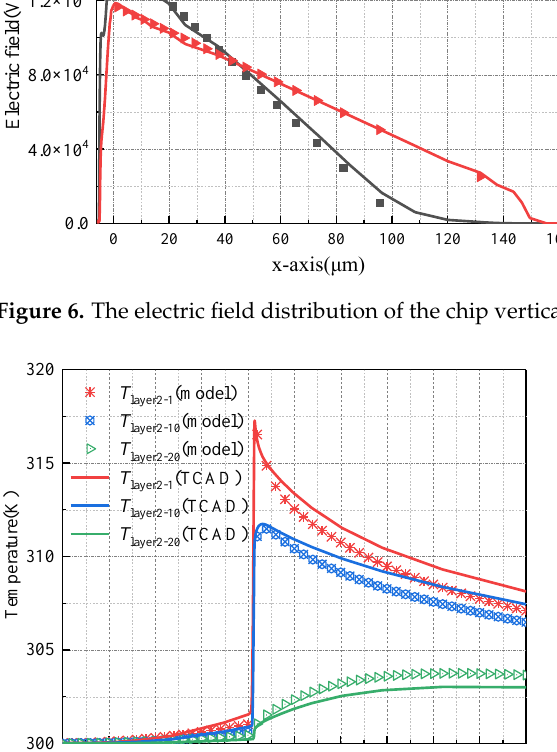
Figure 6. The electric field distribution of the chip vertical path during switching transients.